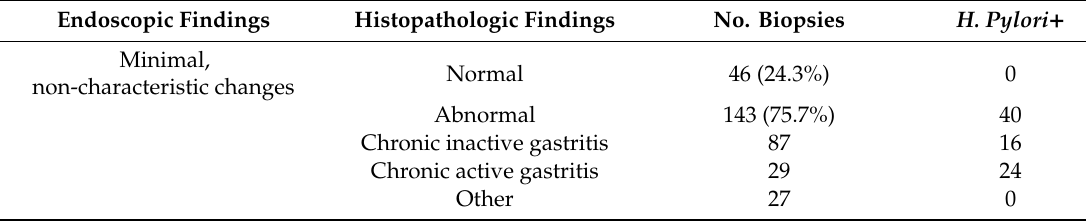
Table 6. Comparative analysis between endoscopic and histopathologic findings.